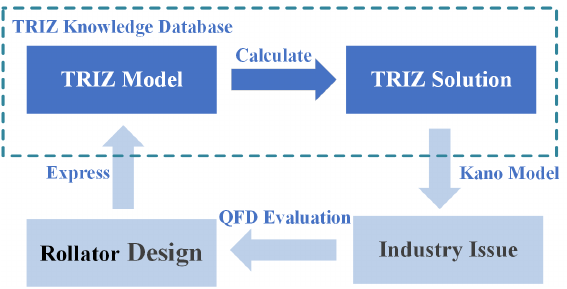
Figure 3. Principle diagram of TRIZ solving problem.